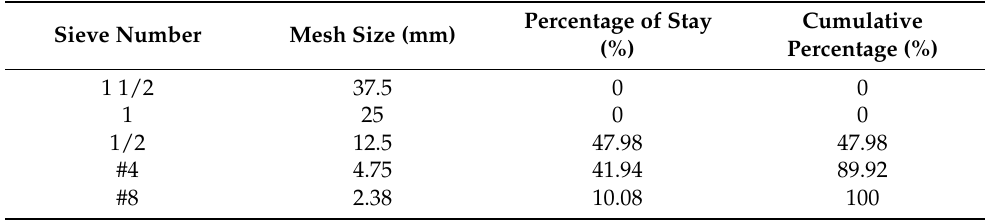
Table 6. Gradation distribution of natural coarse aggregate.